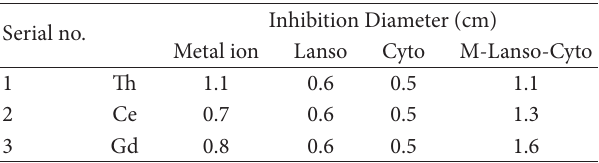
T 9: Sensitivity test of lansoprazole, cytosine and their com- plexes against Aspergillus niger